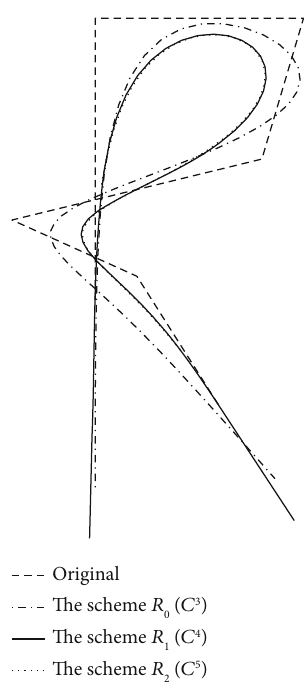
, R , and R schemes after 0 1 2